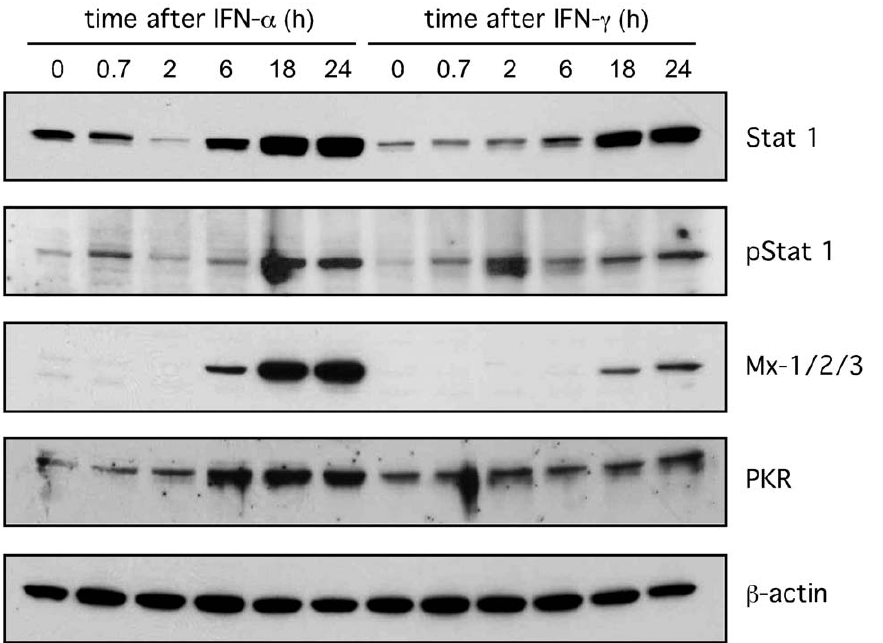
Figure 3. Time-dependent induction by interferons alpha and gamma of innate immune response proteins in primary hepatocytes. Hepatocytes were exposed to either interferons alpha or gamma at 600 units/ml. At time points out to 24 h, as indicated, total cell protein was extracted and analyzed by immunoblot to detect the indicated host proteins. Note that after 2 hours of treatment with interferon gamma, the pSTAT1 increases but not the total STAT1; this is because only a small fraction of the total STAT1 undergoes phosphorylation.